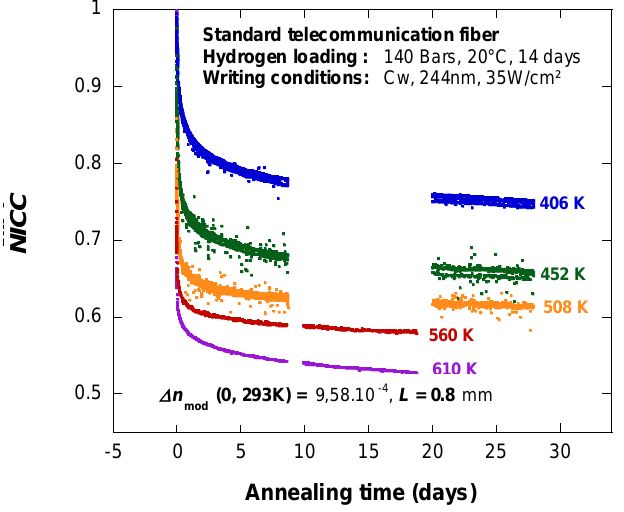
Figure 2. Isothermal decays of identical uniforms Fiber Bragg gratings (FBG) written in -loaded standard telecommunication fiber. an H 2